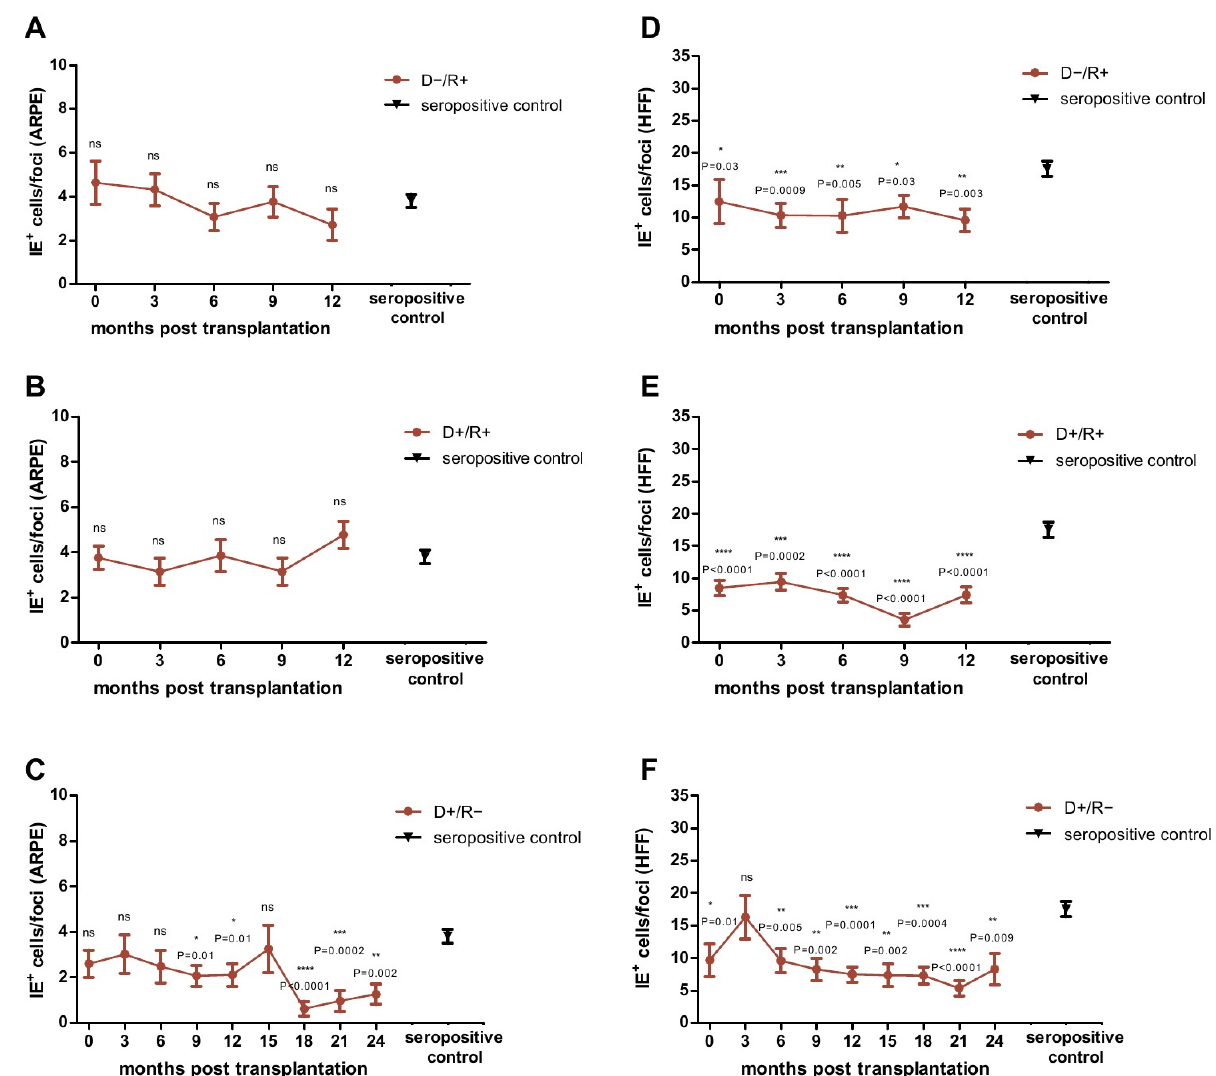
Figure 1. Analysis of the Focus Expansion Assay (FEA) on epithelial cells (ARPE) ( A – C ) and fibroblasts (HFFs) ( D – F ) with plasma obtained from D − /R+ ( A , D ), D+/R+ ( B , E ) and D+/R − ( C , F ) lung transplant recipients (LTRs) after lung transplantation (LTX). D − /R+ and D+/R+ LTRs were tested at 0, 3, 6, 9 and 12 months post LTX. D+/R − LTRs were tested at 0, 3, 6, 9, 12, 15, 18, 21 and 24 months post LTX. Data are shown as mean values ( ± SEM). The mean value of the HCMV-seropositive control cohort (N = 80) is indicated as black triangle ( ± SEM). Plaque sizes at each time point were compared between LTRs and seropositive control patients by ANOVA and Dunn’s post-test; p < 0.05 was considered significant. * p < 0.05; ** p < 0.01; *** p < 0.001; **** p < 0.0001. IE + : HCMV-immediate early positive cells.